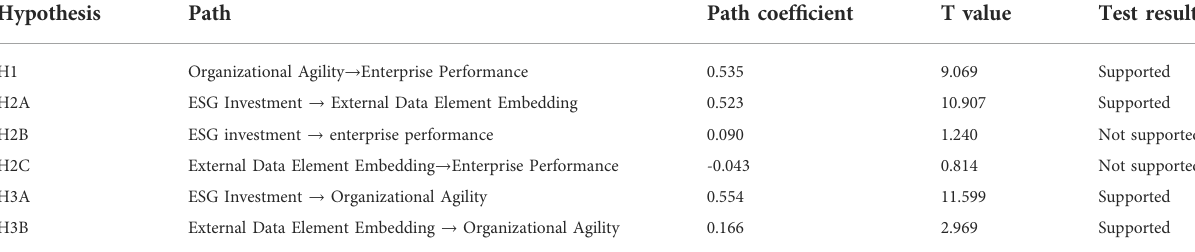
TABLE 3 Hypothesis